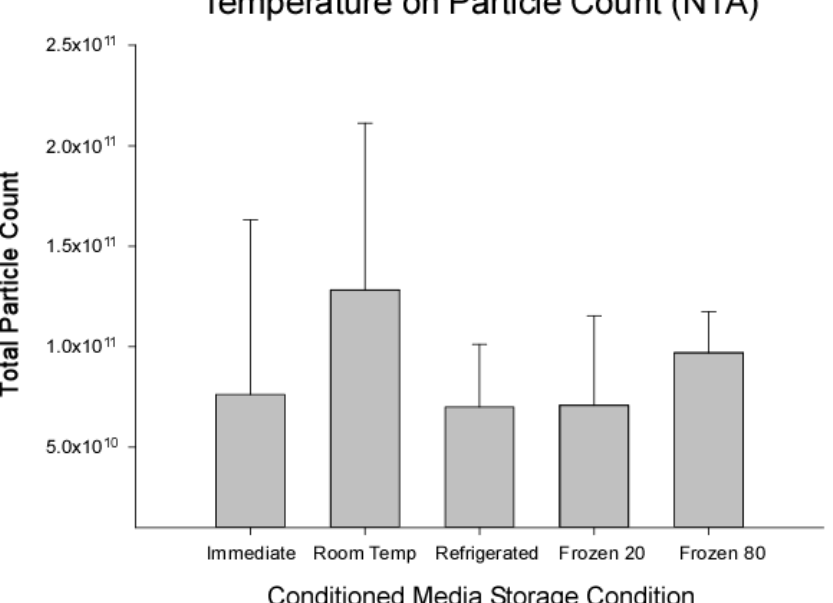
Figure 2. Storage temperature of conditioned media (CM) did not affect particle count measured by Nanoparticle Tracking Analysis (NTA). Particle counts ranged from 6.99 × 10 10 ± 3.12 × 10 10 to 1.28 × 10 11 ± 8.30 × 10 10 . No significant differences in particle count were detected ( p = 0.332) indicating that CM storage temperature prior to isolation did not significantly impact the number of particles isolated from the sample. Data are presented as mean ± standard deviation ( N = 5). Using NTA particle count, EVs released per cell were estimated by averaging all pre- processing storage condition per cell line (Table 2). No significant difference in EV release per cell was detected across the five cell lines ( p = 0.08) indicating that the five cell lines used produced a similar number of EVs in CM during the conditioning period.